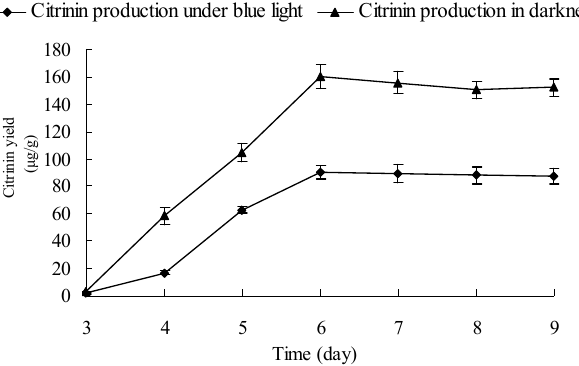
Figure 7. Effect of blue light on citrinin production. Experimental conditions are described in Section 3.8. Monascus was cultured by liquid oscillatory fermentation at 30 °C, 180 r/min for 9 days under blue light (0.16 mW/cm 2 ) and in darkness. The citrinin production in different culture condition were determined by high-performance liquid chromatograph.